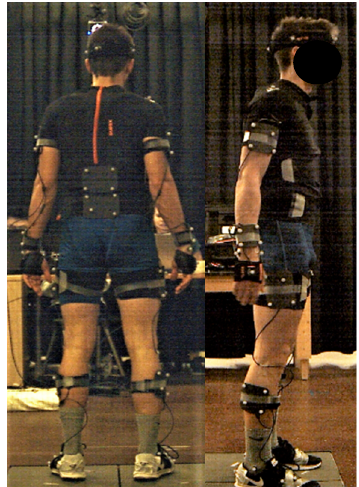
Figure 1. Participant setup. A cluster-based optical marker set was worn on top of the Xsens IMU suit.